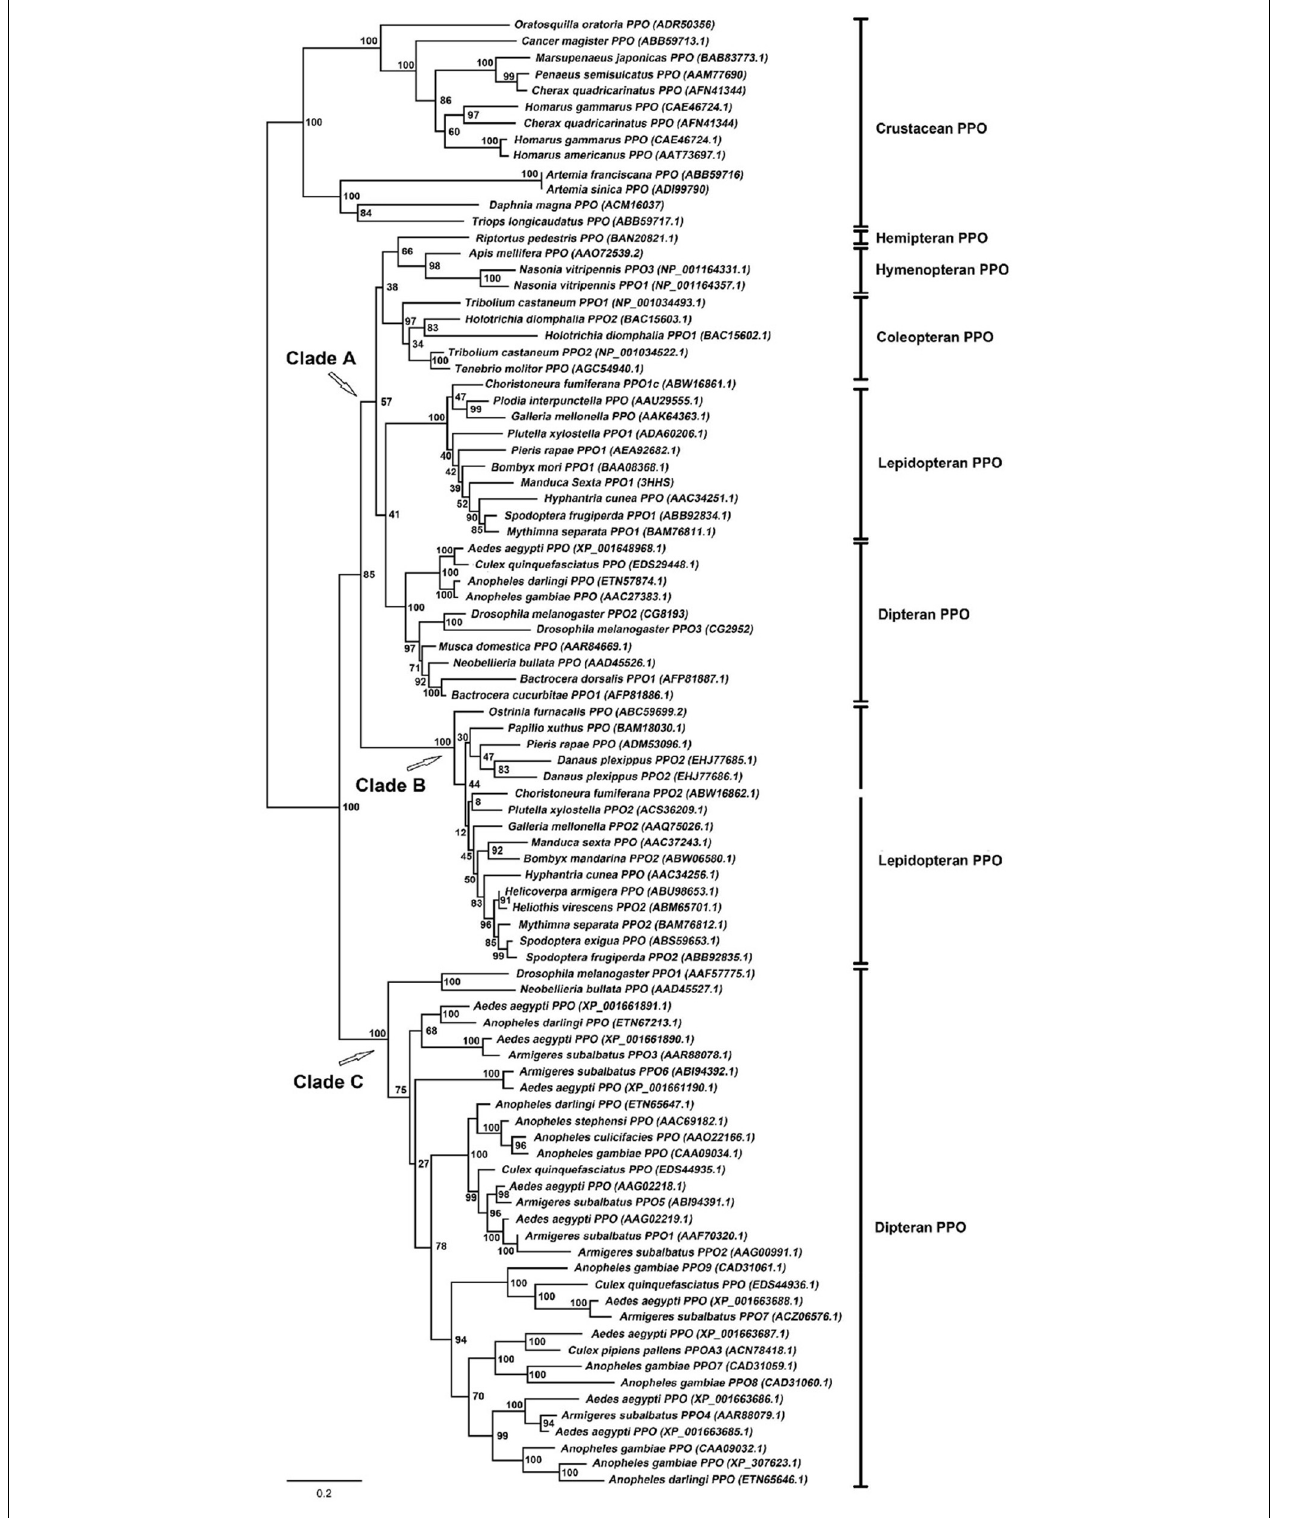
FIGURE 3 | Maximum-likelihood tree of insect prophenoloxidases calculated using the RAxML method via the CIPRES Science Gateway (Miller et al., 2010). Crustacean PPOs were used as an outgroup. The PPO genes from various insect species are indicated along with their NCBI accession numbers.